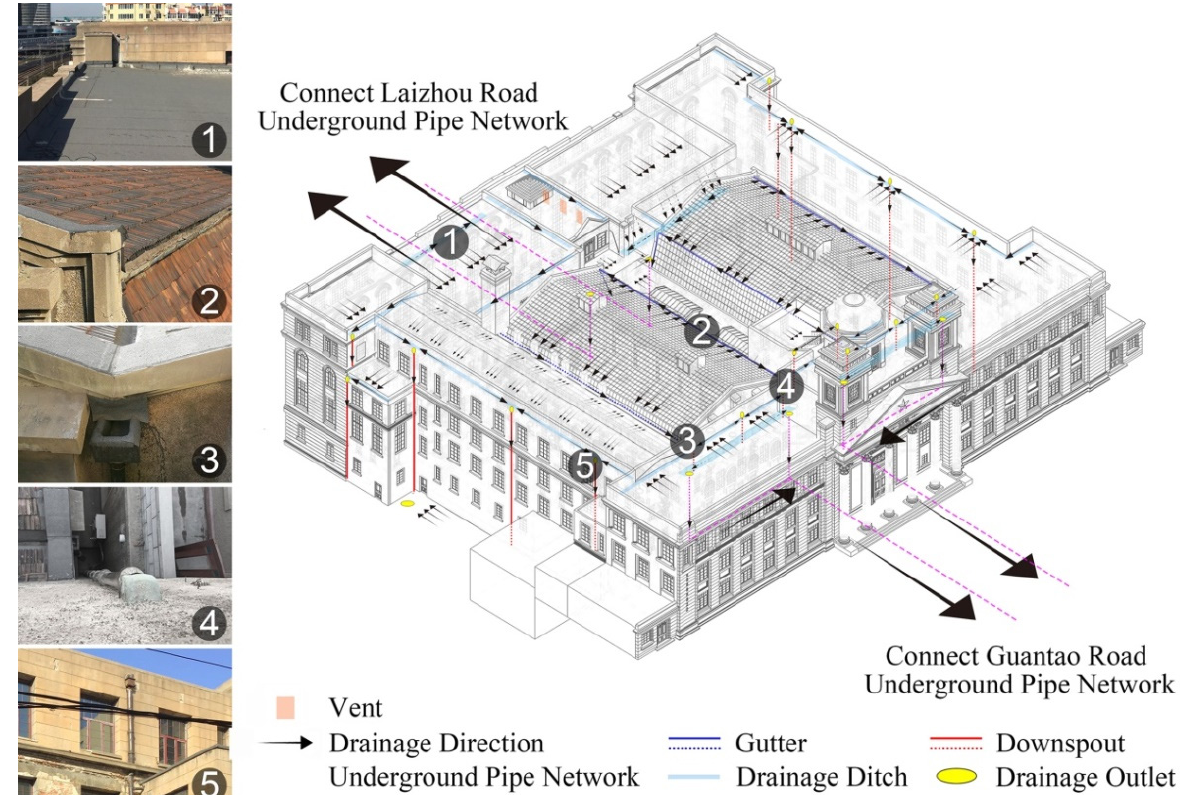
Figure 17. Water Drainage System.